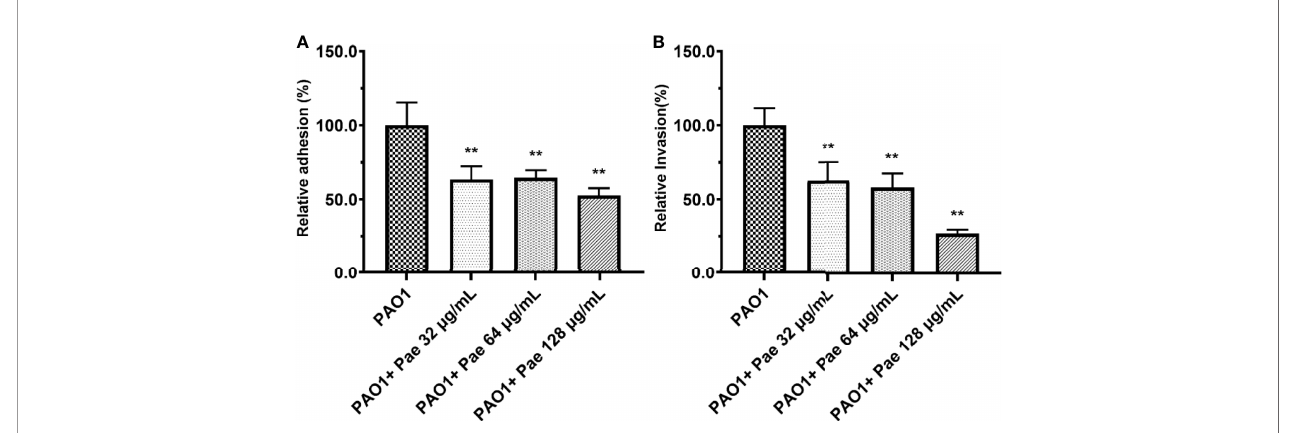
FIGURE 6 | Adhesion (A) and invasion (B) were tested in PAO1-infected RAW264.7 (MOI = 25:1) with paeonol treatment for 4 hours. “ PAO1+Pae 32 m g/mL ” , “ PAO1+Pae 64 m g/mL ” , “ PAO1+Pae 128 m g/mL ” indicate that RAW264.7 cells were infected with PAO1 and treated with paeonol. The bacteria were cultivated and counted on a TSB plate. All data were expressed as means ± SD (n=3). ** P < 0.01 vs the control group.